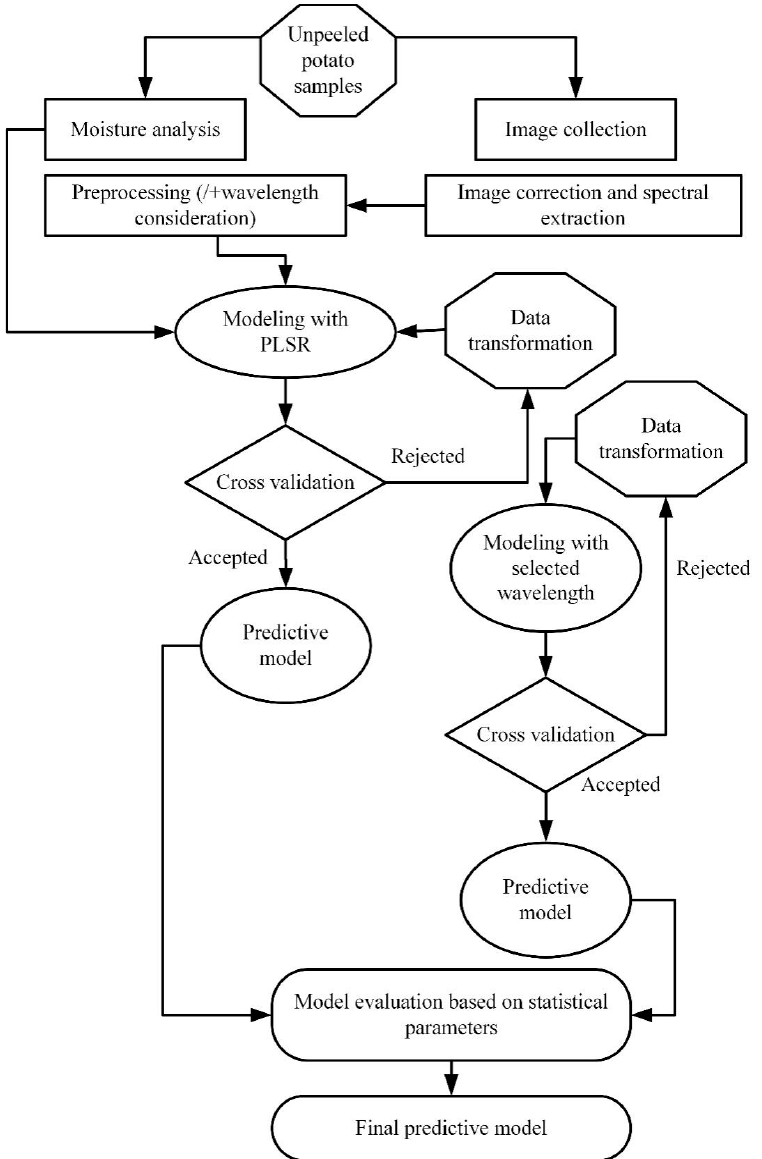
Figure 3. Schematic workflow of data processing.